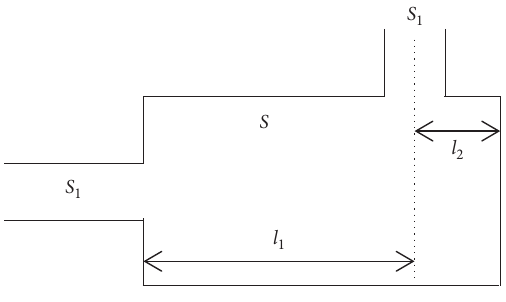
Figure 2: Diagram of a side outlet muffler.